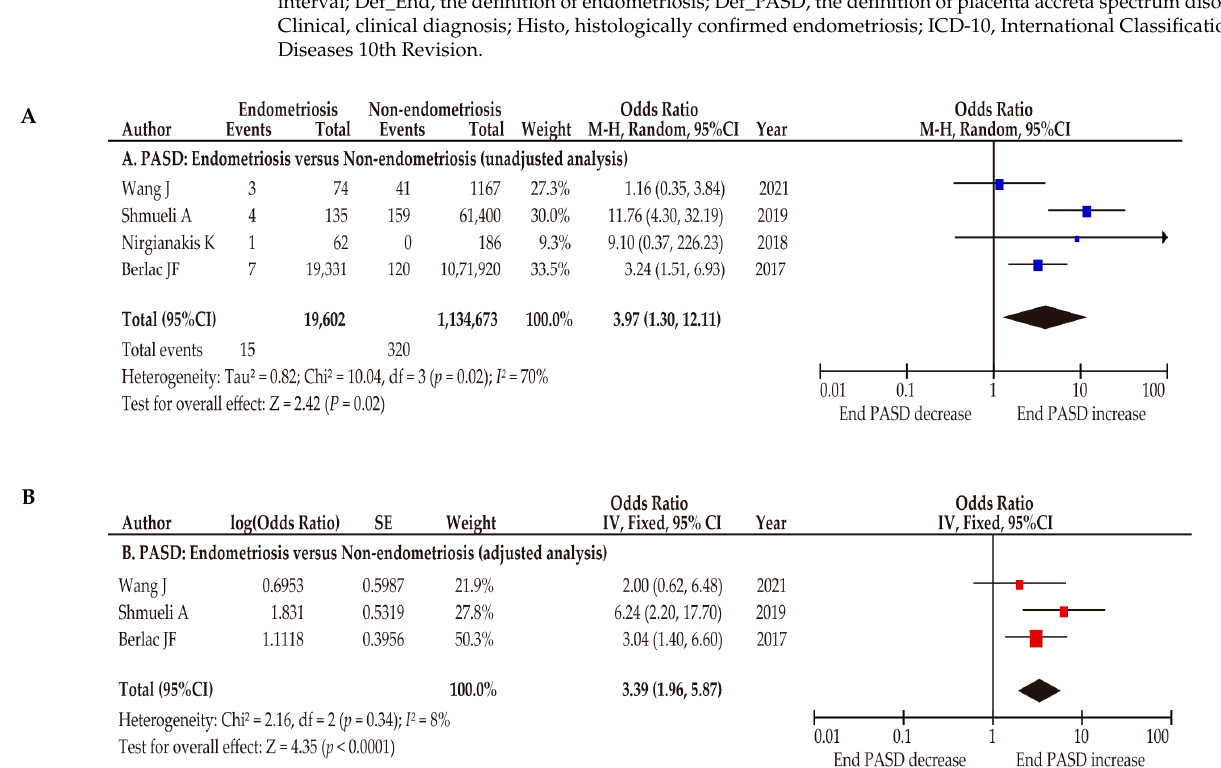
Figure 2. Effect of endometriosis on the prevalence of placenta accreta spectrum disorder. The pooled odds ratios (ORs) for the ( A ) unadjusted analysis of PASD and ( B ) adjusted analysis of PASD for women with endometriosis and women without endometriosis. Forest plots were ordered within the stratum by relative weight (%) and the publication year of the study. Substantial heterogeneity was observed during the unadjusted analysis ( A : I 2 = 70%), and low heterogeneity was observed during the adjusted analysis ( B : I 2 = 8%). Some values might be slightly different from the original values because calculations were performed using RevMan version 5.4.1. Abbreviations: PASD, placenta accreta spectrum disorder; End, endometriosis; OR, odds ratio; CI, confidence interval; SE, standard